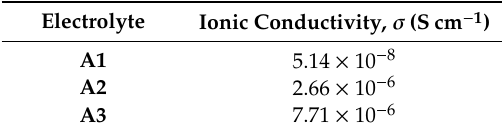
Table 3. Ionic conductivity for the electrolyte system with different glycerol concentration at room temperature.